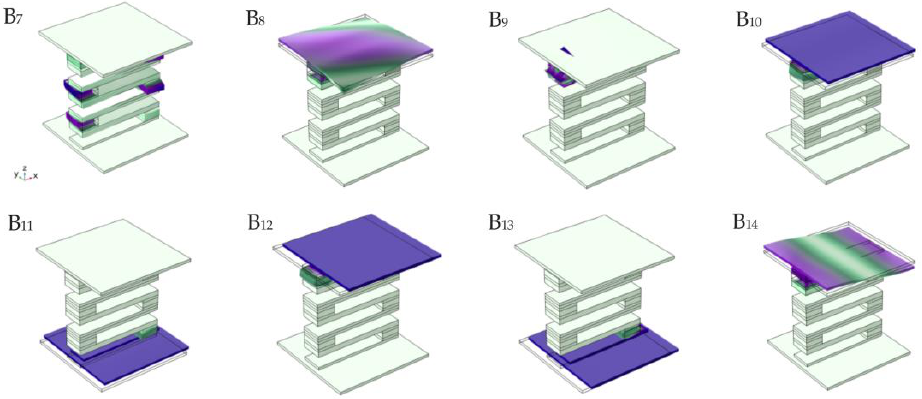
Figure 8. The displacement fields of eigenmodes labeled within the second band gap in Figure 5a.